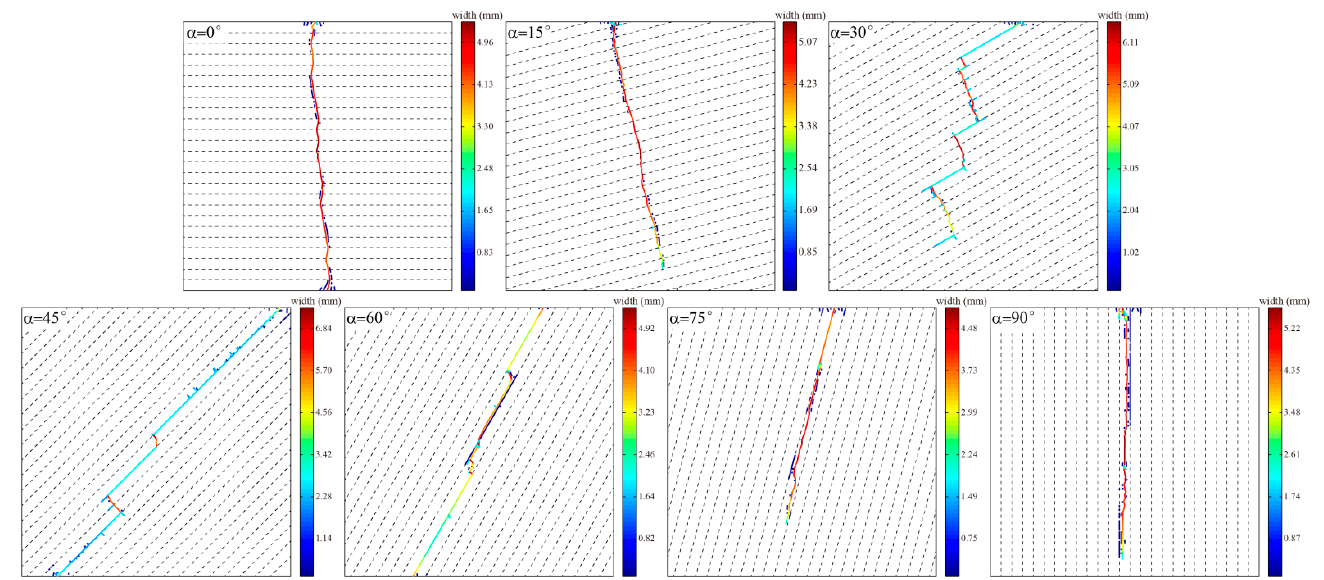
Figure 5. Fracture paths. Overall, the fracture paths extended along the direction of maximum principal stress. The larger the bedding angle, the stronger the effect of the BP and the stronger the ability to capture HFs.